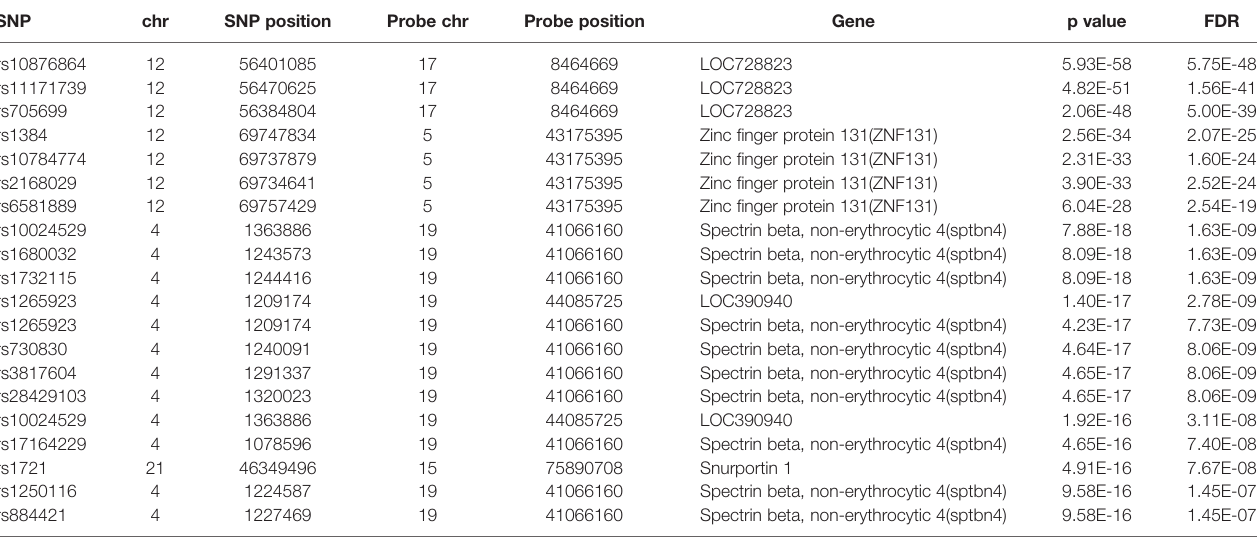
TABLE 2 | The top 20 most signi fi cant m 6 A-trans-eQTLs in sepsis.